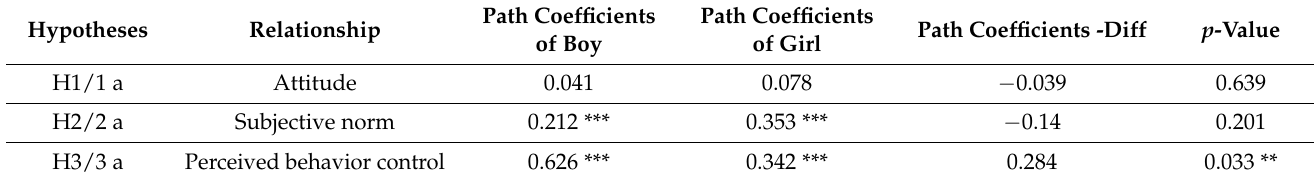
Table 4. Result of PLS-MGA (Gender).